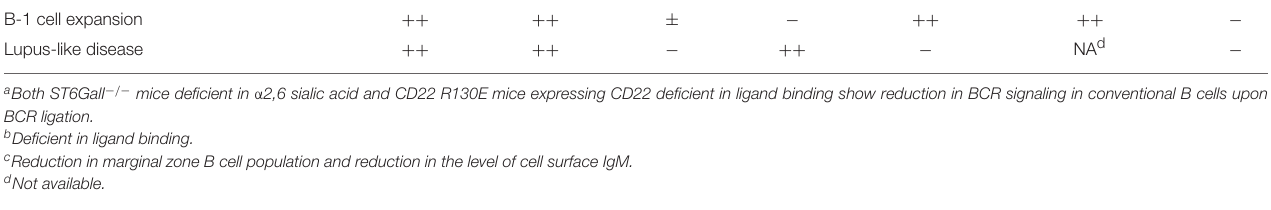
Table 1 ), suggesting that different inhibitory B cell co-receptors regulate distinct B cell